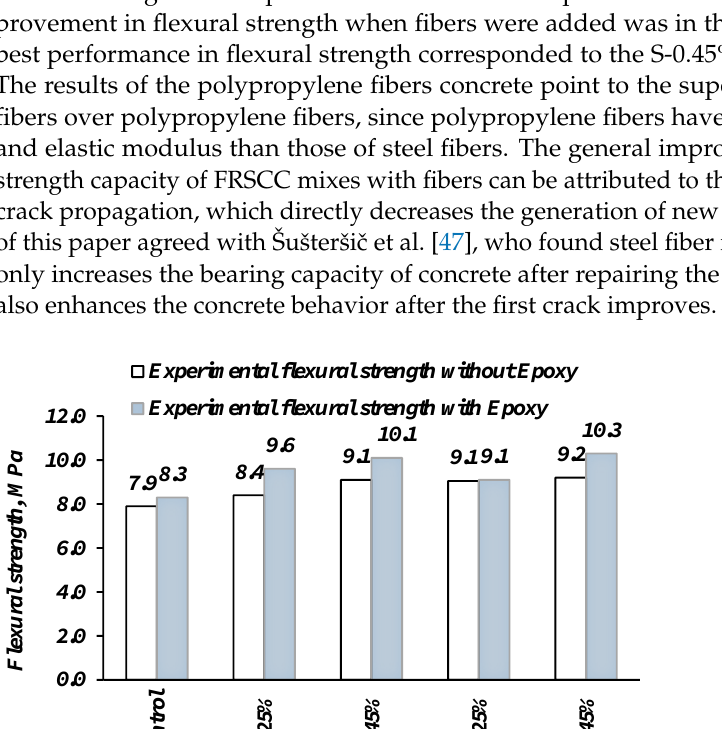
Figure 8. Effect of fibers on the shear strength.